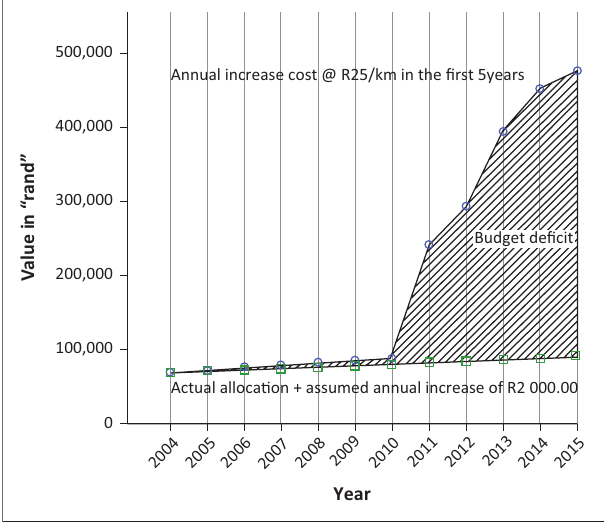
FIGURE 1: Illustration of road maintenance budget deficit model in Makhado LM 2015.